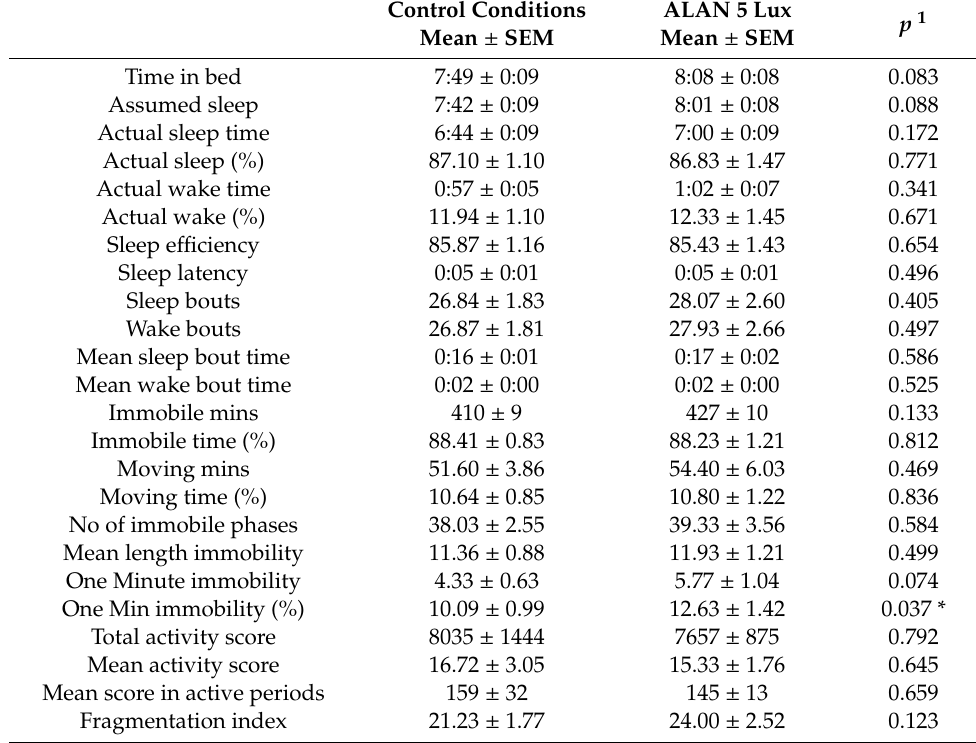
Table 3. Parameters of sleep quality in young volunteers exposed to ALAN 5 lux during the entire night, n =